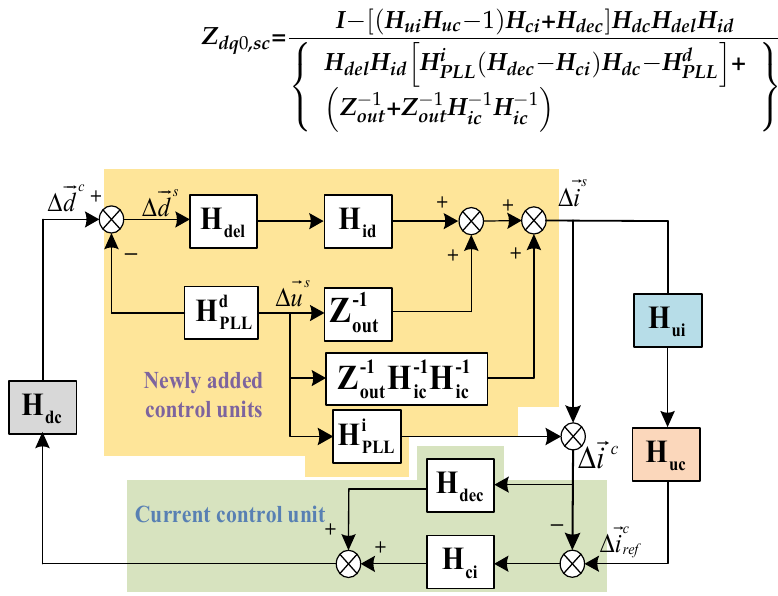
Figure 4. Small-signal control diagram of LCL-TFSCI.